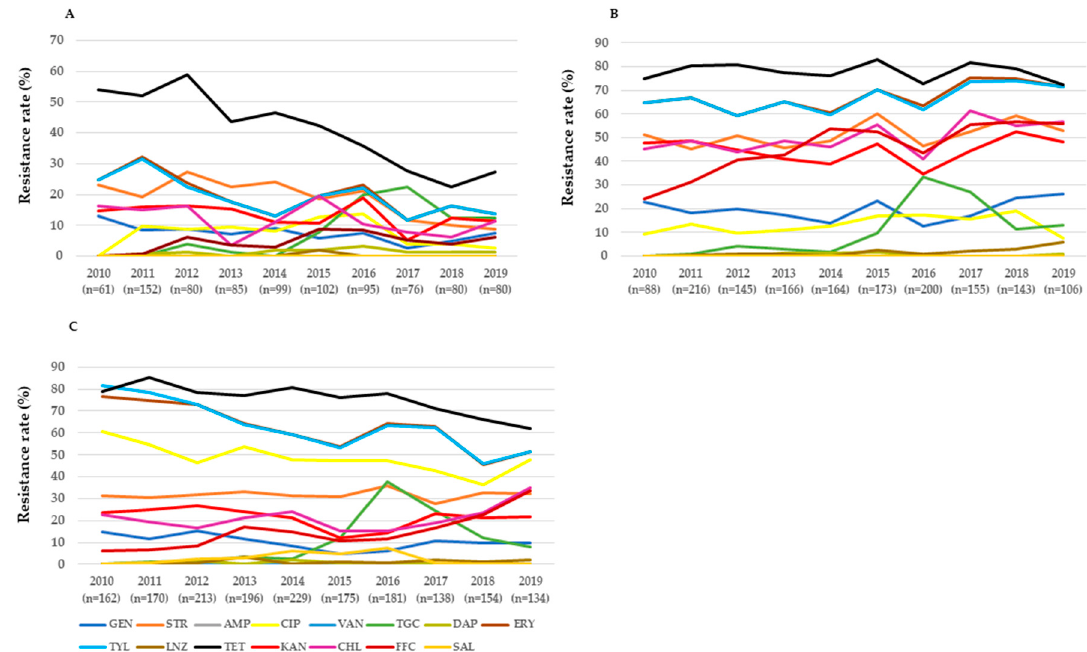
Figure 2. Antimicrobial resistance trend of E. faecalis isolates recovered from cattle ( A ), pigs ( B ), and chickens ( C ) in Korea from 2010 to 2019. Abbreviations: AMP, ampicillin; CIP, ciprofloxacin; CHL, chloramphenicol; DAP, daptomycin; ERY, erythromycin; FFC, florfenicol; GEN, gentamicin; KAN, kanamycin; LIN, linezolid; SAL, salinomycin; STR, streptomycin; TET, tetracycline; TGC, tigecycline, TYL, tylosin; and VAN, vancomycin.